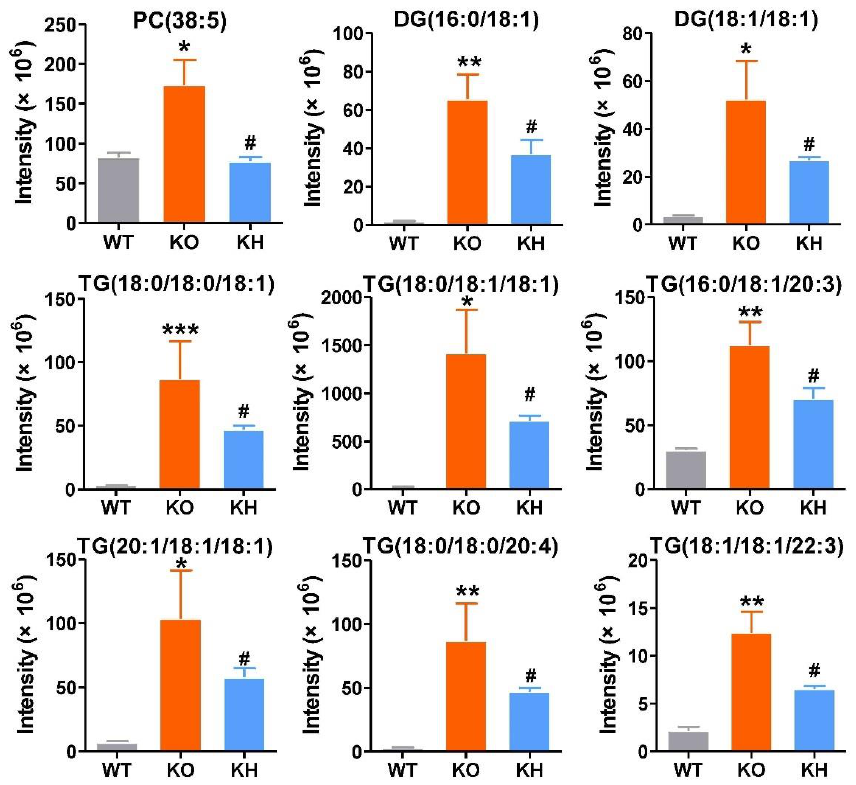
Figure 7. Nine lipid species were remarkable reversibly decreased by HTE in liver of Lepr rats. Values are the mean ± SEM ( n = 4). * p < 0.05, ** p < 0.01, *** p < 0.001, compared to WT group; # p < 0.05 versus KO group.